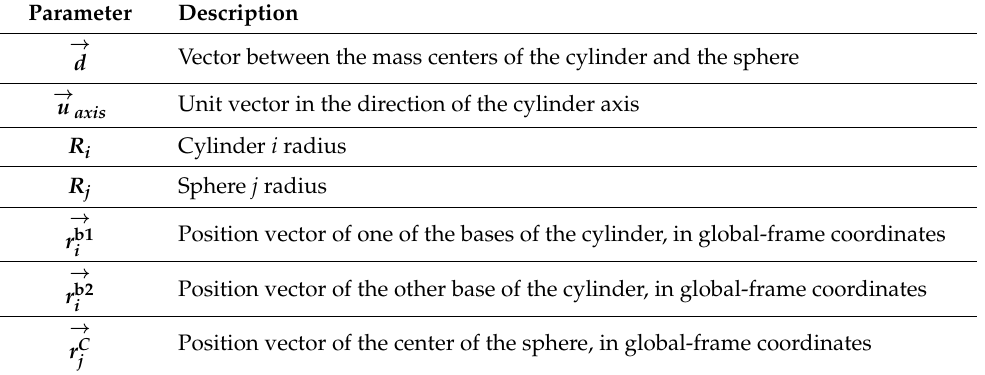
Table 3. Parameters required to calculate the indentation between a cylinder and a sphere, according to the described algorithm.